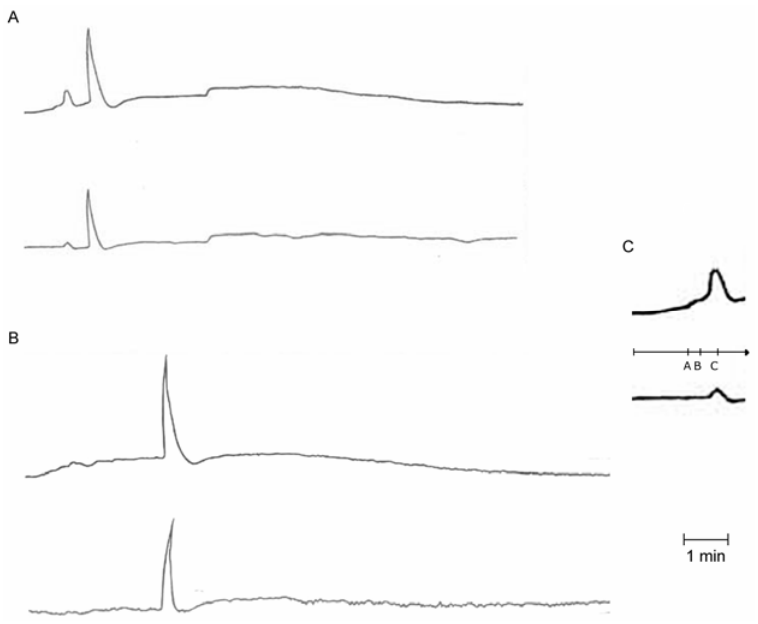
Fig. 2 – A – Upper row: extra-cellular potassium concentration versus time, lower row: simultaneous extra-cellular potential (mV) versus time. The pulse of potassium concentration is from 6 to 10 mEq/l. B – Same slice one hour later. C – Detail of the initial response shown in A. The labels A, B and C in C picture show three phases of initial growth, two linear and the last non-linear “active” response.